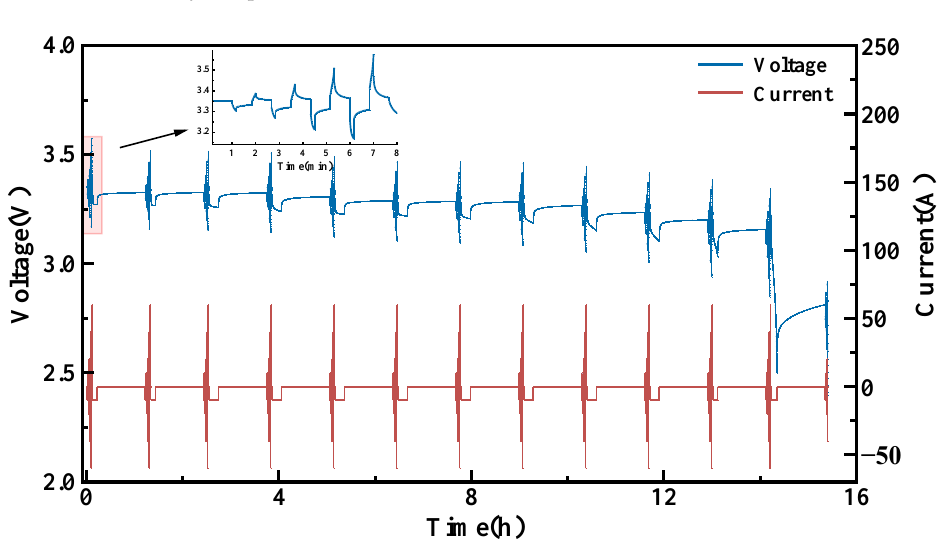
Figure 3. Voltage and current of HPPC experiments.